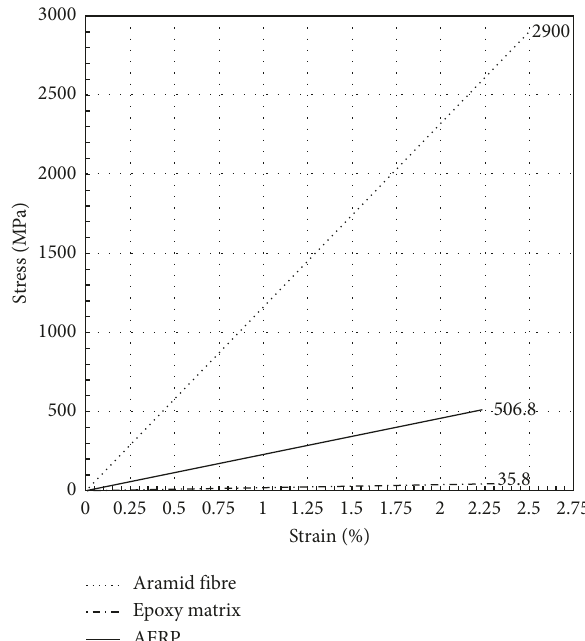
Figure 2: Tensile stress-strain curves of aramid fibre, epoxy matrix, and AFRP coupon with volume fraction V f ≤